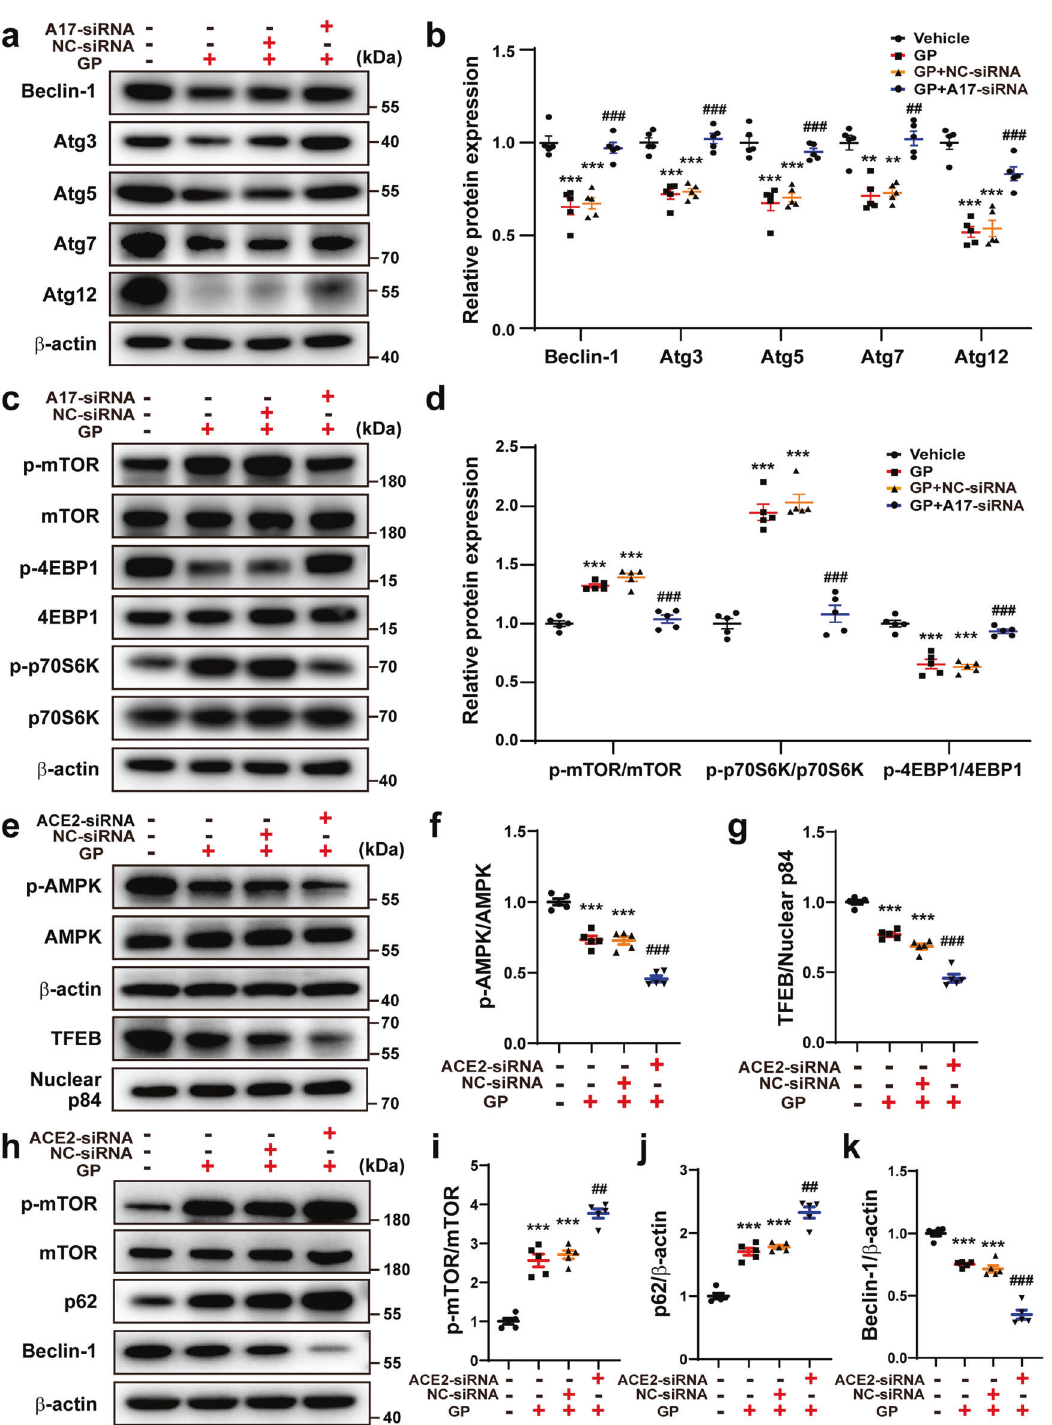
Fig. 7 Effects of ADAM17 or ACE2 de fi ciency on autophagy-related proteins. a , b Representative Western blot images and quantitative analyses of protein expression of Beclin1, Atg3, Atg5, Atg7, and Atg12 in four groups of differentiated H9c2 cells treated with vehicle, GP, GP + NC-siRNA and GP + ADAM17-siRNA, respectively. c , d Representative Western blot images and analysis of phosphorylated mTOR, mTOR, phosphorylated p70S6K, p70S6K, phosphorylated 4EBP1 and 4EBP1 protein expression in differentiated H9c2 cells treated as above. Mean values were derived from 5 independent experiments. e – g Representative Western blot images and quantitative analysis of phosphorylated AMPK, AMPK, and TFEB protein expression in differentiated H9c2 cells treated with vehicle, GP, GP + NC-siRNA and GP + ACE2-siRNA, respectively. h – k Representative Western blot images and analysis of phosphorylated mTOR, mTOR, p62 and Beclin1 protein expression in differentiated H9c2 cells treated as above. Mean values were obtained from fi ve independent experiments. Data were presented as mean ± SEM. * P < 0.05, ** P < 0.01, *** P < 0.001 vs. the vehicle group; # P < 0.05, ## P < 0.01, ### P < 0.001 vs. the GP + NC-siRNA